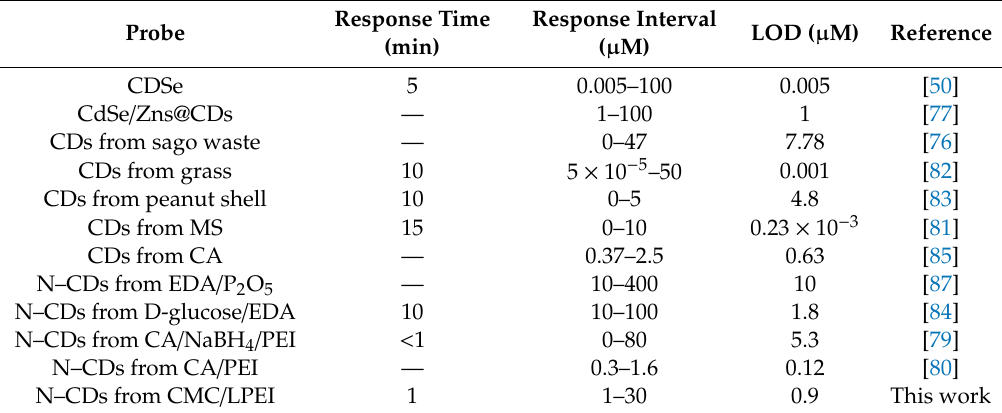
Table 1. Summary of some fluorescent probes for Cu 2 +